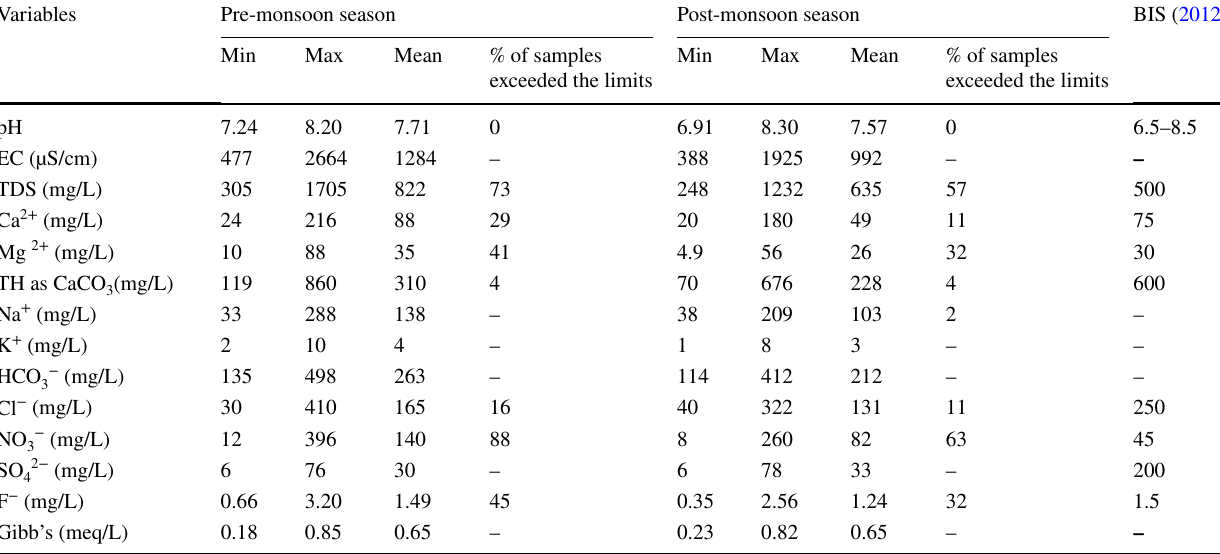
Table 3 Statistics of groundwater chemistry of the study area